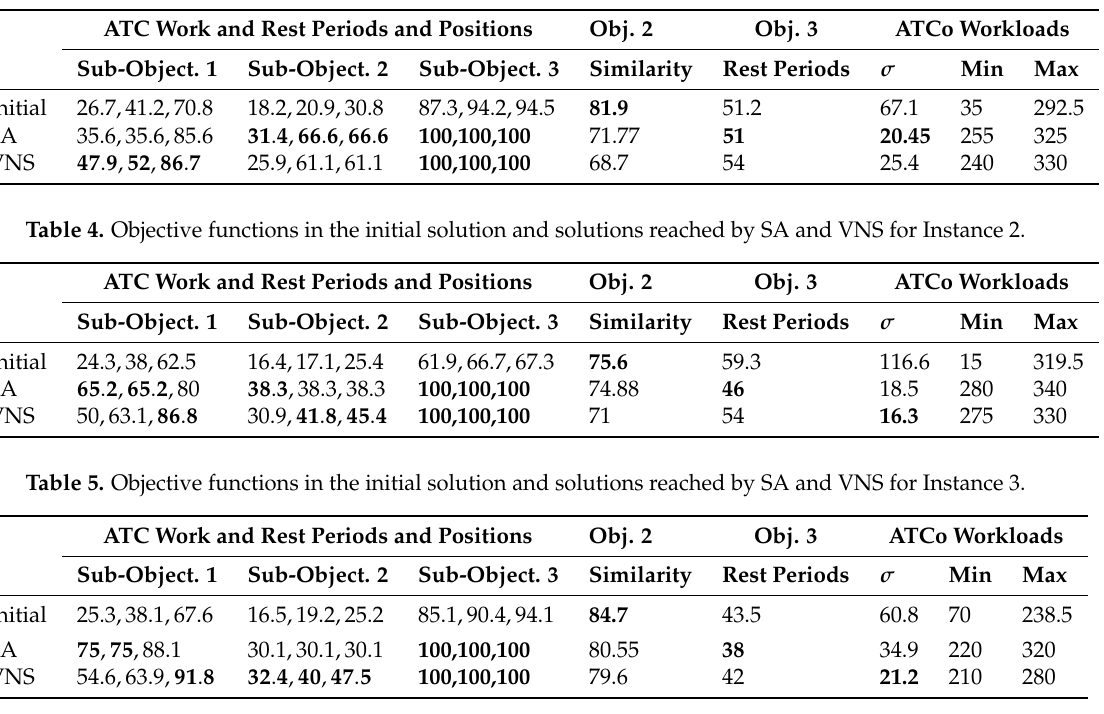
Table 3. Objective functions in the initial solution and solutions reached by SA and VNS for Instance 1. ATC Work and Rest Periods and Positions Sub-Object. 1